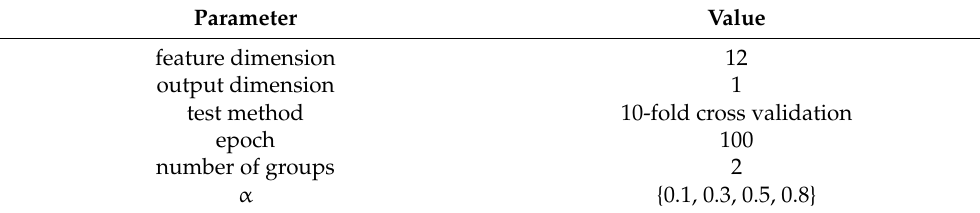
Table 3. Parameter settings of the ADSGL